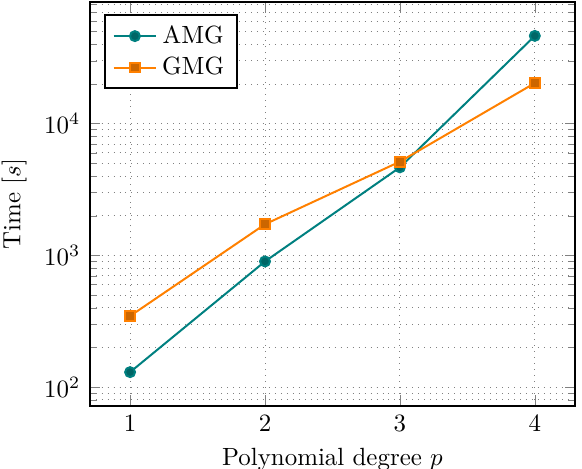
Figure 10. Comparison of the sparse-matrix-vector product (SpMV) and matrix-free application (MFMV) for varying polynomial degrees. Again, (cid:96) = 7 and ε = 4 × 10 − 3 .